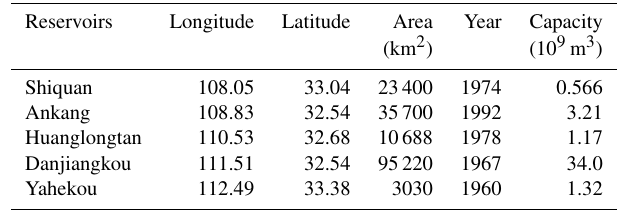
Table 3. Information of the five major reservoirs in the Han River